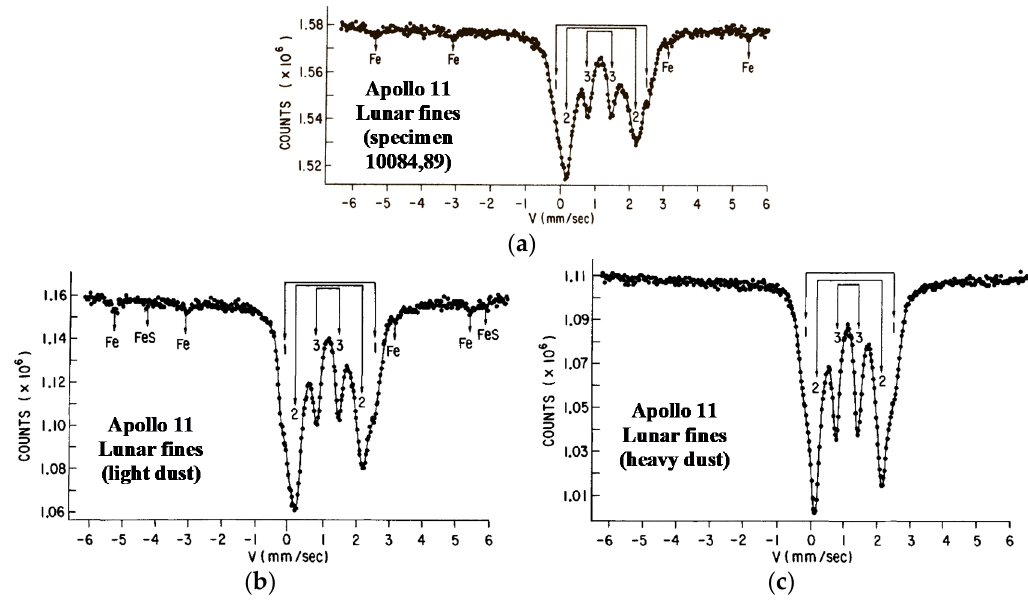
Figure 43. Mössbauer spectra of Lunar fines (Apollo 11) measured at room temperature: specimen 10084,89 ( a ), light dust from fines ( b ), and heavy dust from fines ( c ). Fe is metallic iron alloy, FeS is troilite, 1 represents the M1 sites in pyroxene, 2 represents the M2 sites in pyroxene, and 3 is ilmenite. Adapted from [106].